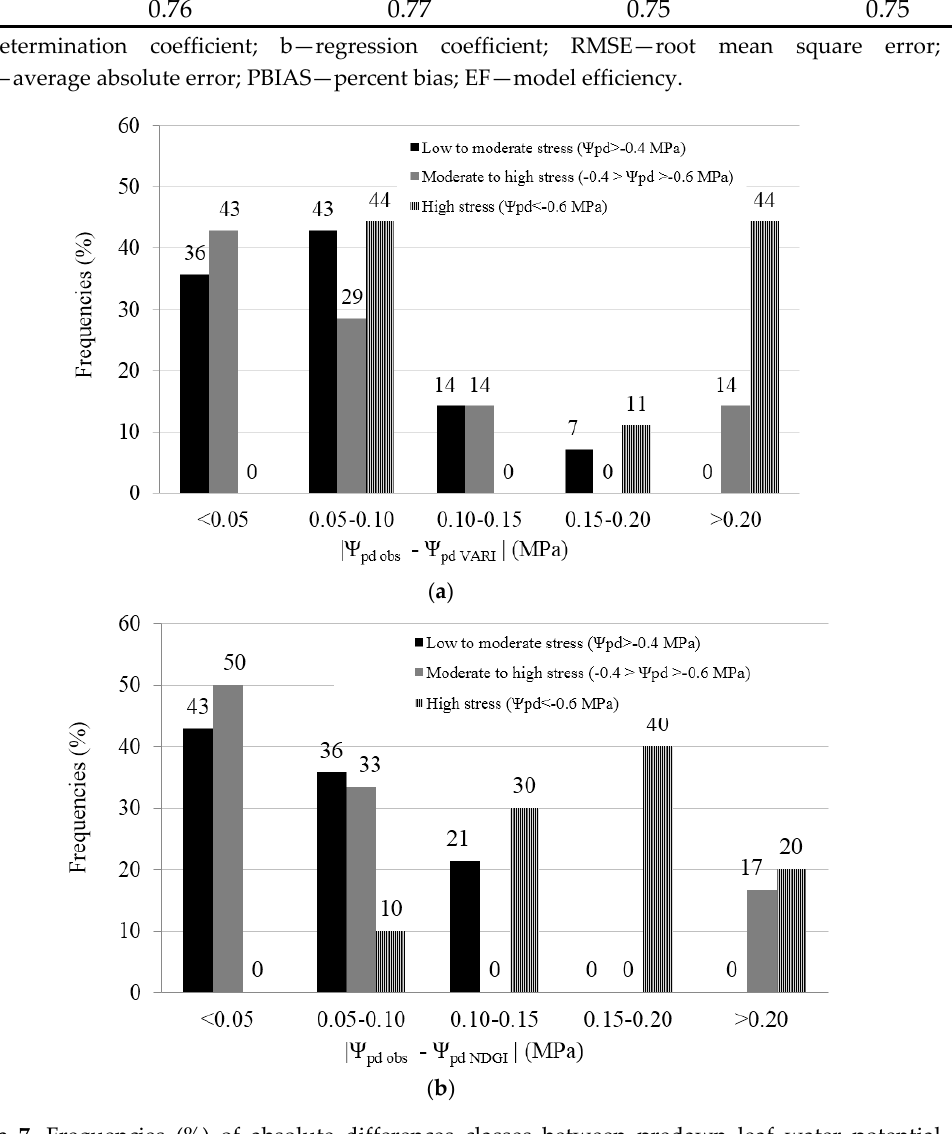
Figure 7. Frequencies (%) of absolute differences classes between predawn leaf water potential observed ( Ψ pd obs ) and predicted using ( a ) VARI ( Ψ pd VARI ) and ( b ) NDGI ( Ψ pd NDGI ) for the testing dataset. The value on the top of the bars stands for the